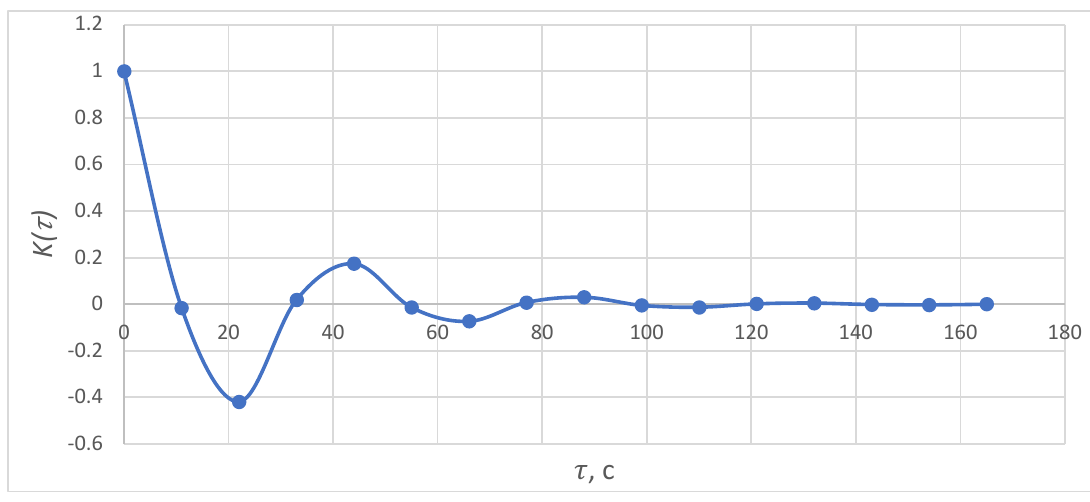
Figure 4. Theoretical NCF curve with a VFD. Figure 2. Theoretical NCF curve with a VFD. Table 8. The time